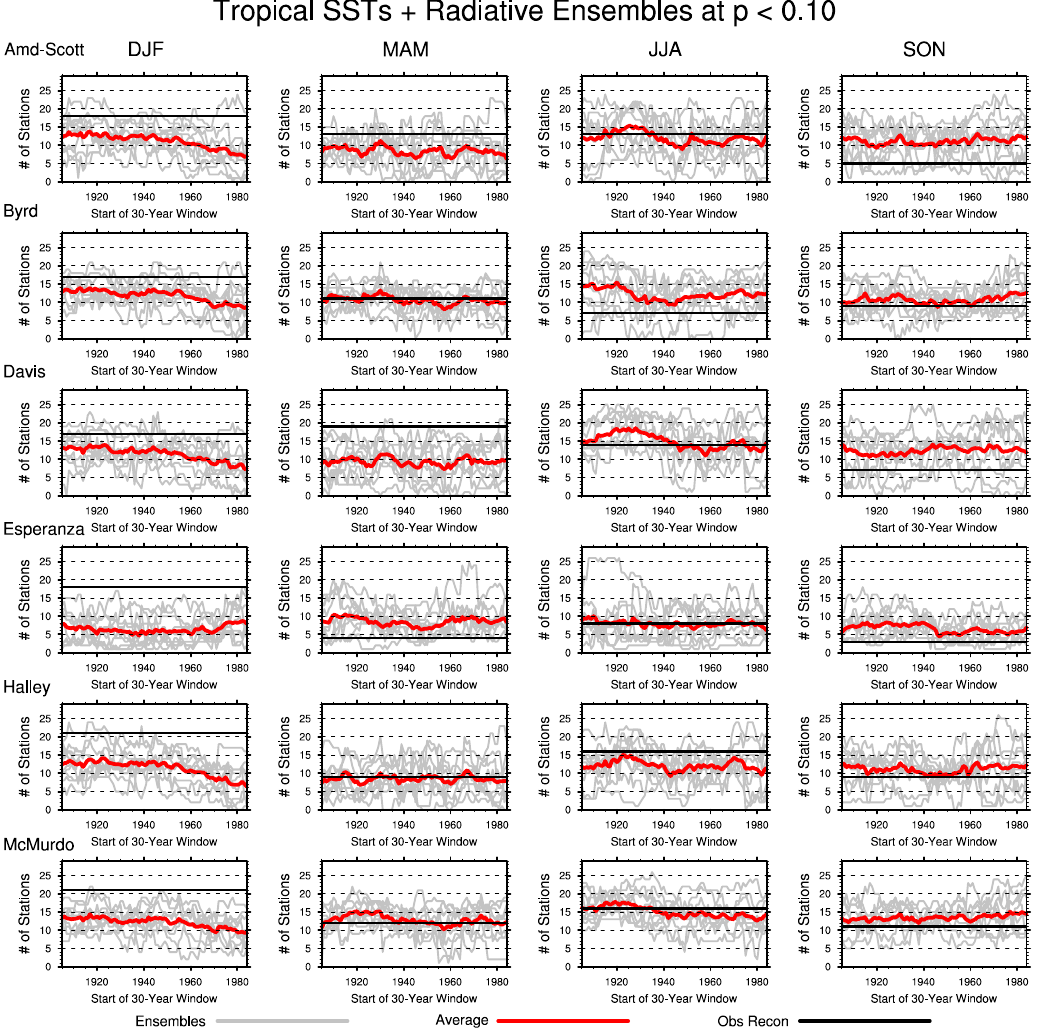
Figure 7. Number of midlatitude stations that are significantly correlated at p < 0.10 to Antarctic stations in moving 30-year windows. The rows depict the midlatitude pressure relationships for 6 Antarctic stations—Amundsen-Scott, Byrd, Davis, Esperanza, Halley and McMurdo. For each station and season, each ensemble member is plotted (gray lines) from the Tropical SSTs + Radiative CAM5 experiment, with the mean number of stations also shown (red line). The number of stations that were used in the observationally-based reconstruction [28] is indicated by a horizontal black line on each plot.